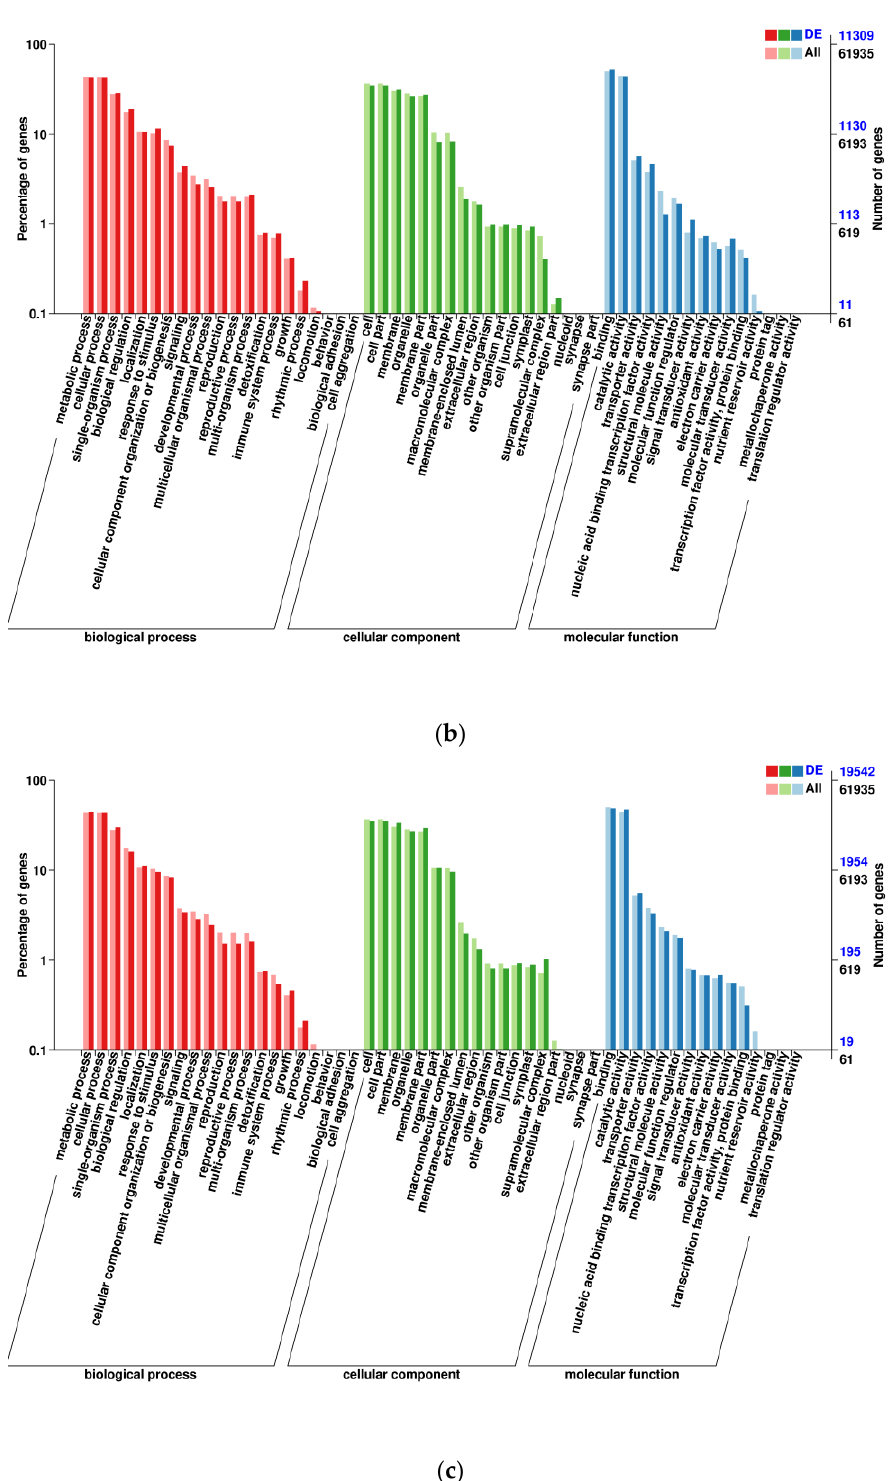
Figure 3. Statistical graph of GO annotation classification of differentially expressed genes. ( a ) mRO vs. mLO; ( b ) mRO vs. mSO; ( c ) mSO vs. mLO. mOR, mOS, and mOL represent mature roots, mature stems, and mature leaves, respectively.